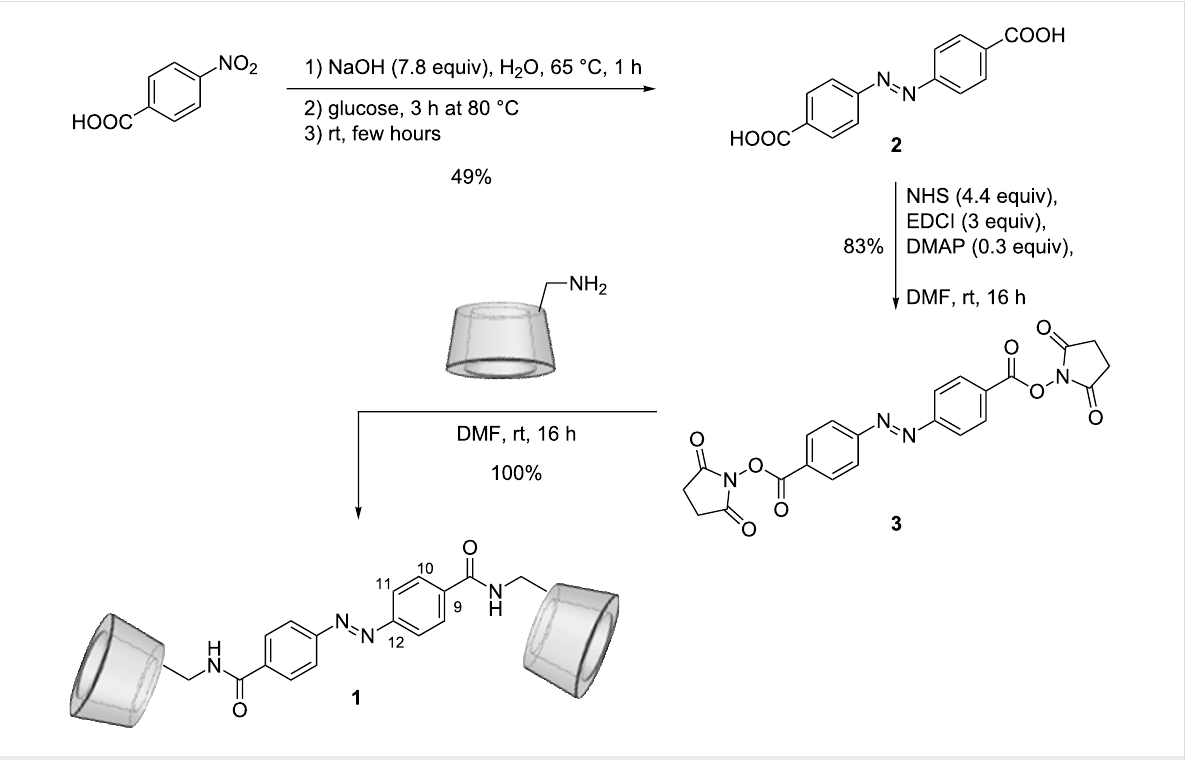
Scheme 1: Synthesis pathway of the dimer AZO-CDim 1